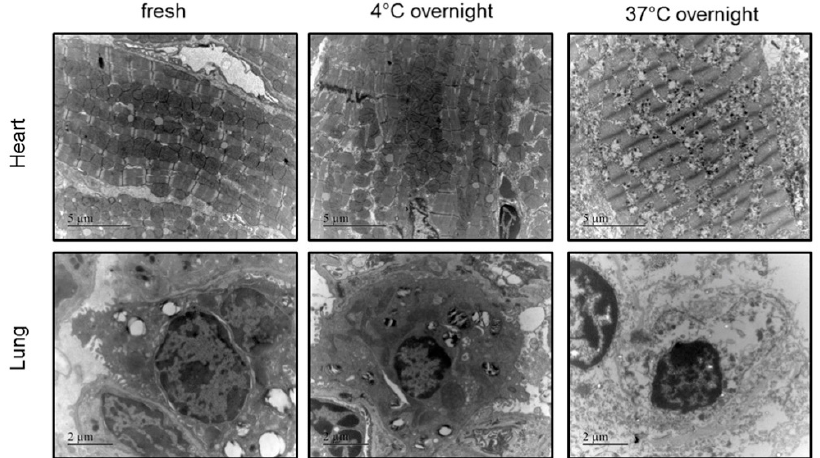
Figure A4. Representative electronic microscopy images of heart and lung samples at ×7000 magnification for heart (scale bar: 5 µm) and ×12,000 magnification for lung (scale bar: 2 µm).